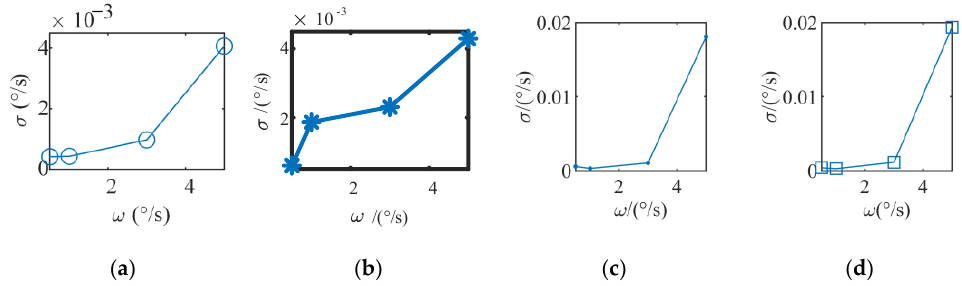
Figure 14. Average velocity error at different angular velocities: ( a ) the angular error with the ω x when ω y is equal to zero; ( b ) the angular error with the ω y when ω x is equal to zero; ( c ) the angular error with the ω x when ω x is equal to ω y ; ( d ) the angular error with the ω y when ω x is equal to ω y .